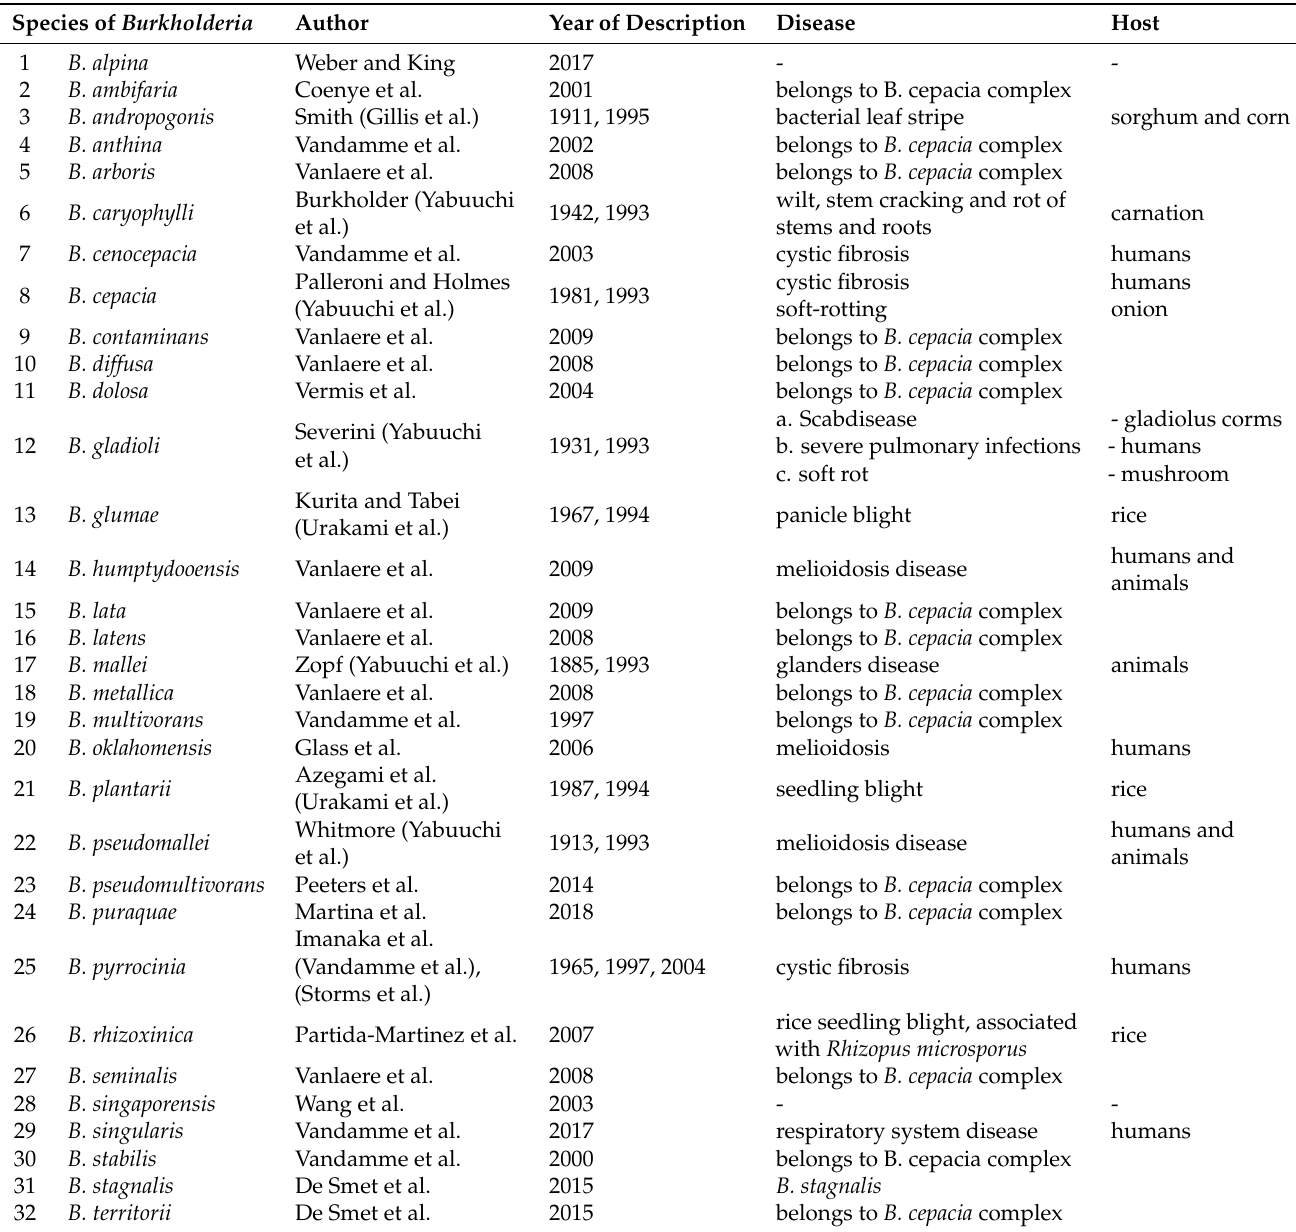
Table 1. List of species of Burkholderia mentioned in the current